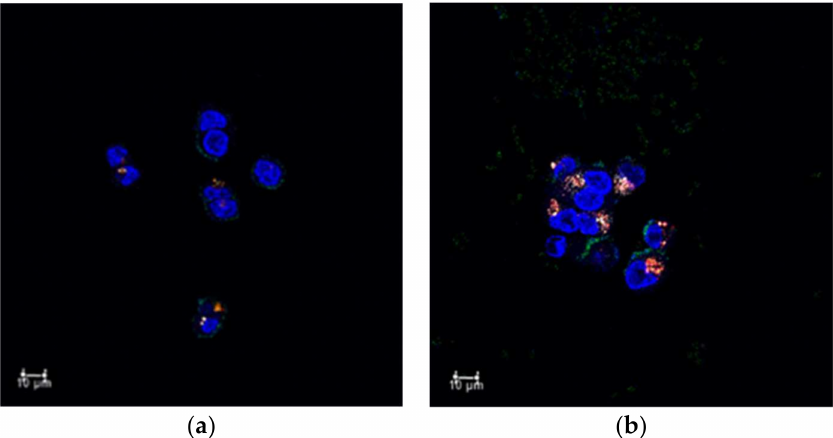
Figure 6. Confocal laser scanning microscope (CLSM) images showing internalization of curcumin ( a ) and curcumin-loaded PECs ( b ). HCT116 human colon cancer cells were incubated with curcumin or Cy5.5-labled curcumin-loaded PECs, which were pretreated with mimetic GI tract conditions. After 12 h of incubation, the cells were stained with Lysotracker DND-Red to label the endosome/lysosomes, and then fixed with paraformaldehyde. The fixed cells were then washed twice with PBS and further stained and mounted with 4 (cid:48) ,6-diamidino-2-phenylindole (DAPI)-containing mounting medium. The fluorescence of the Cy 5.5-labeled curcumin-loaded PECs, curcumin, endosome/lysosomes, and DAPI was observed using a CLSM with appropriate excitation and emission